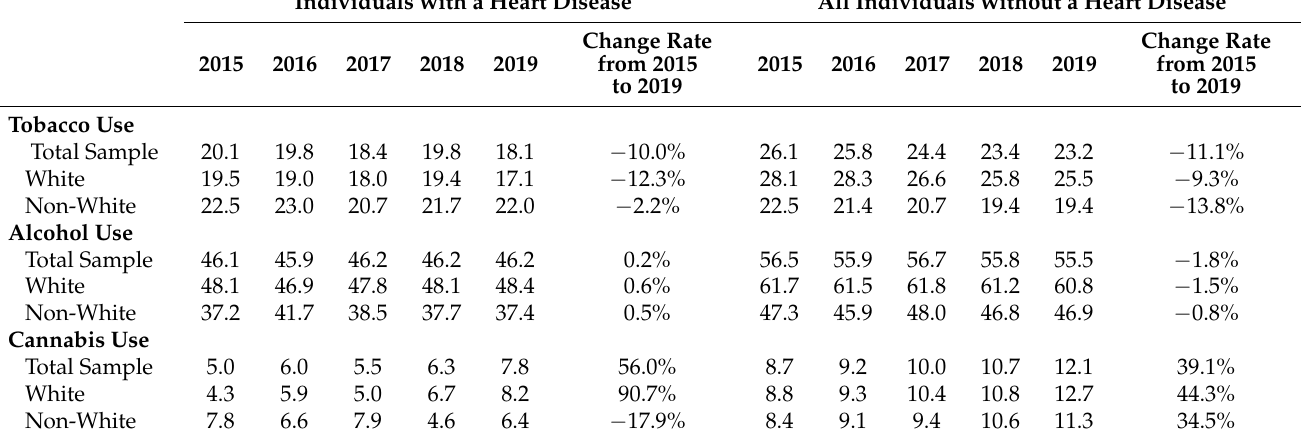
Table A1. Test of trends in tobacco, alcohol, and cannabis use among adults with and without heart disease by year.